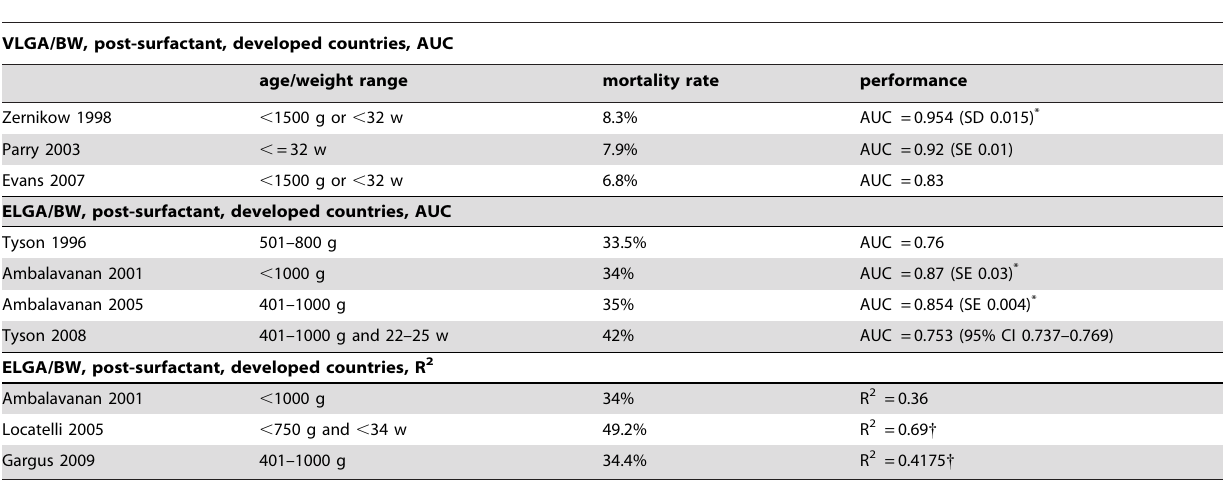
Table 2. Comparison of predictive performance of models as reported in the development